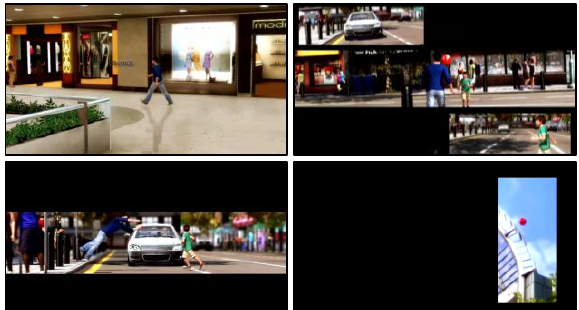
Figure 4 | ‘Passivity’ is translated in soft actions/touches non- obligatory. Pictures extracted from the ‘Chapter 3: Father and Son’ of Heavy Rain